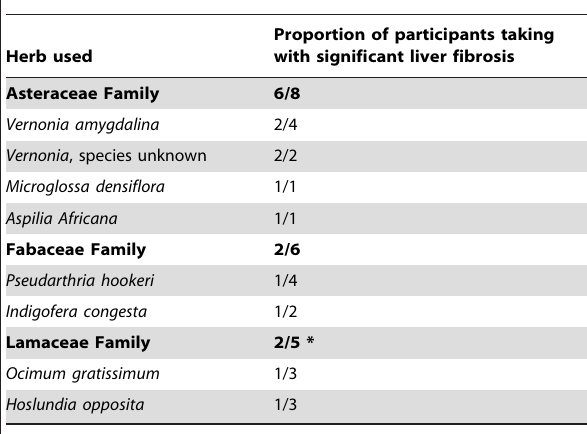
Table 5. Association of herbs with significant liver fibrosis in all participants.